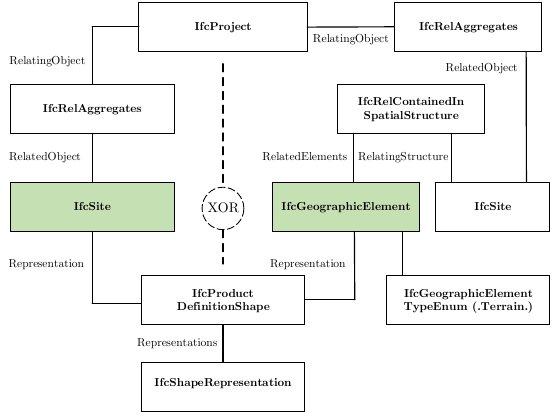
Figure 2. In IfcTerrain the Terrain is either be objectified as IfcSite (IFC 2x3) or IfcGeographicElement (IFC 4)